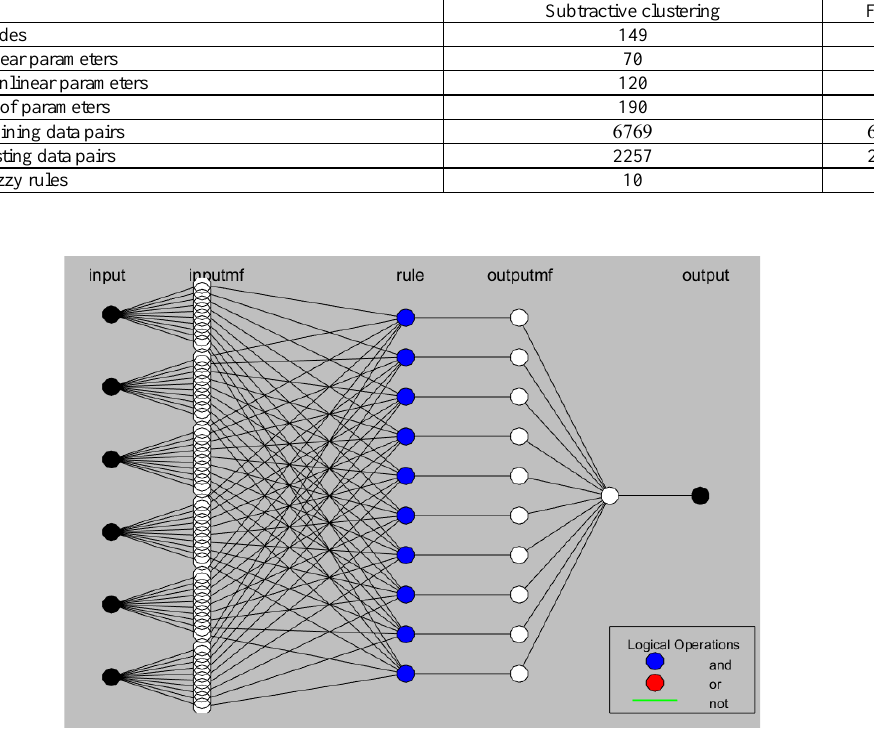
Figure 7. ANFIS structure for formulating input data using subtractive clustering method